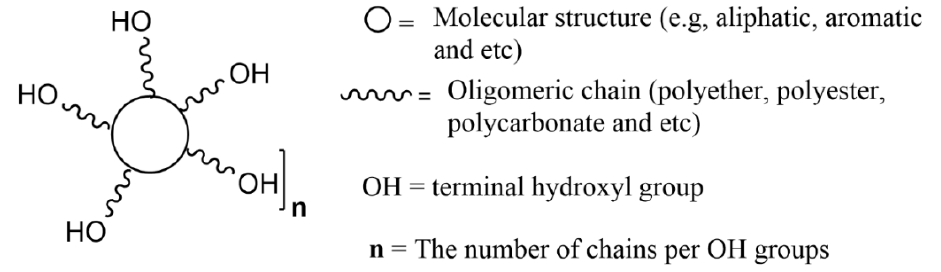
Figure 9. Scheme of the general formula of polyol, adapted from [2].